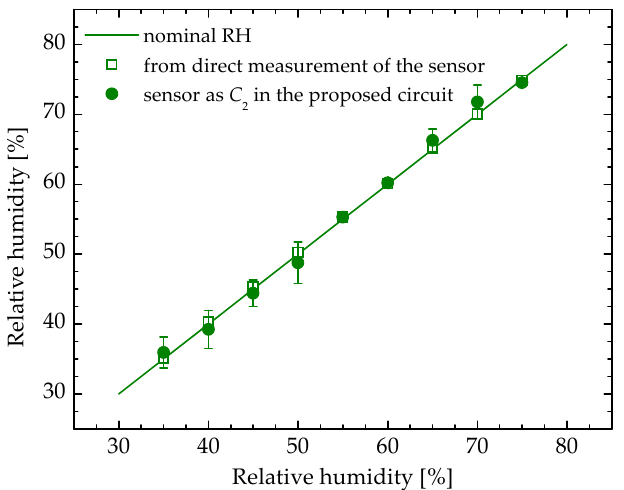
Figure 7. Experimental results concerning the measurement of RH% performed by employing a commercial capacitive sensor.